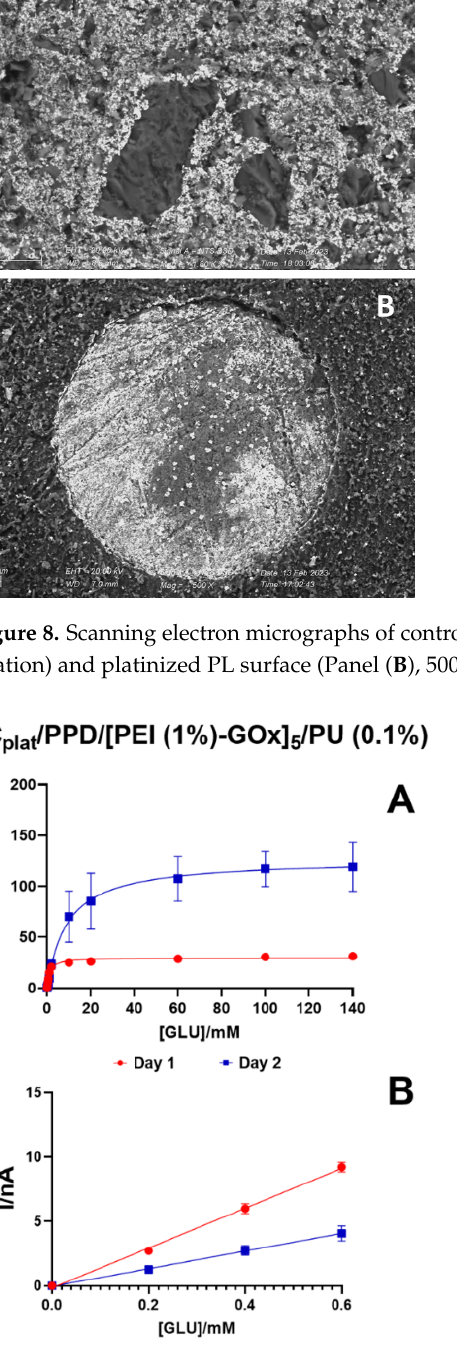
Figure 9. Representative plot of glucose biosensor C plat /PPD/[PEI(1%) − GOx] 5 /PU(0.1%). The non-linear fitting of data (Panel ( A )) was performed in the range 0–140 mM of concentrations of glucose. Meanwhile, the linear fitting of data (Panel ( B )) was performed in the 0–0.6 mM range. Data were obtained from Day 1 (red plot) and Day 2 (blue plot) calibrations. C plat : platinized bare carbon; PPD: poly-orthophenylenediamine polymer; PEI: polyetileneimmine; GOx: glucose oxidase; PU: polyurethane. The subscript number indicates the number of layers of the biosensor component. Calibrations were performed on Day 1 (red plot) and Day 2 (blue plot) after the bio- sensors’ conservation at − 80°C.